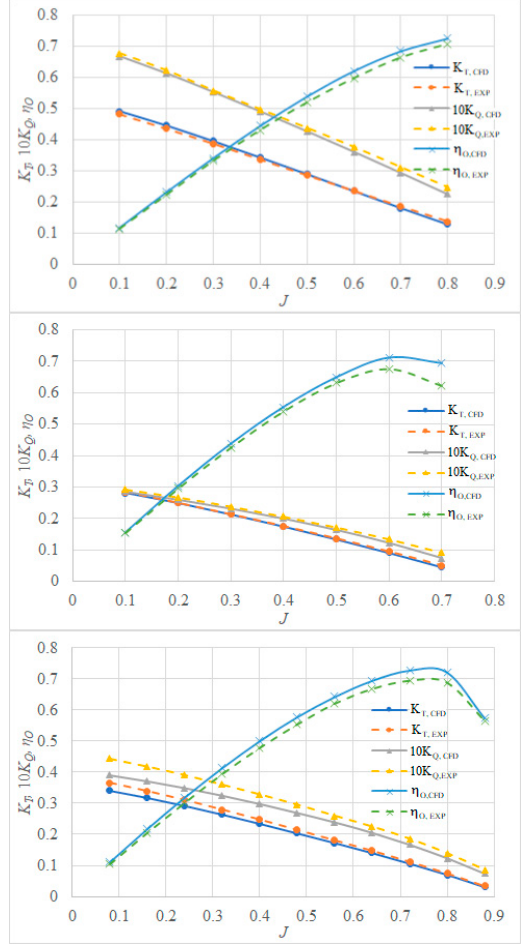
Figure 7. The validation study for open water characteristics of KP505 ( upper ), KP458 ( middle ) and WB ( lower ).